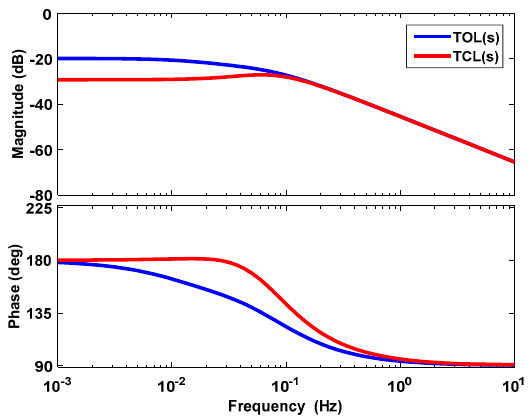
Figure 5. Bode plots of T OL (s) and T CL (s).